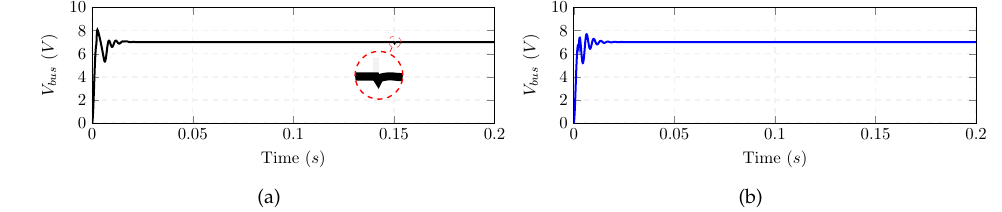
Figure 13. The improved dynamic response using the proposed method: ( a ) sequential loading; and ( b ) full